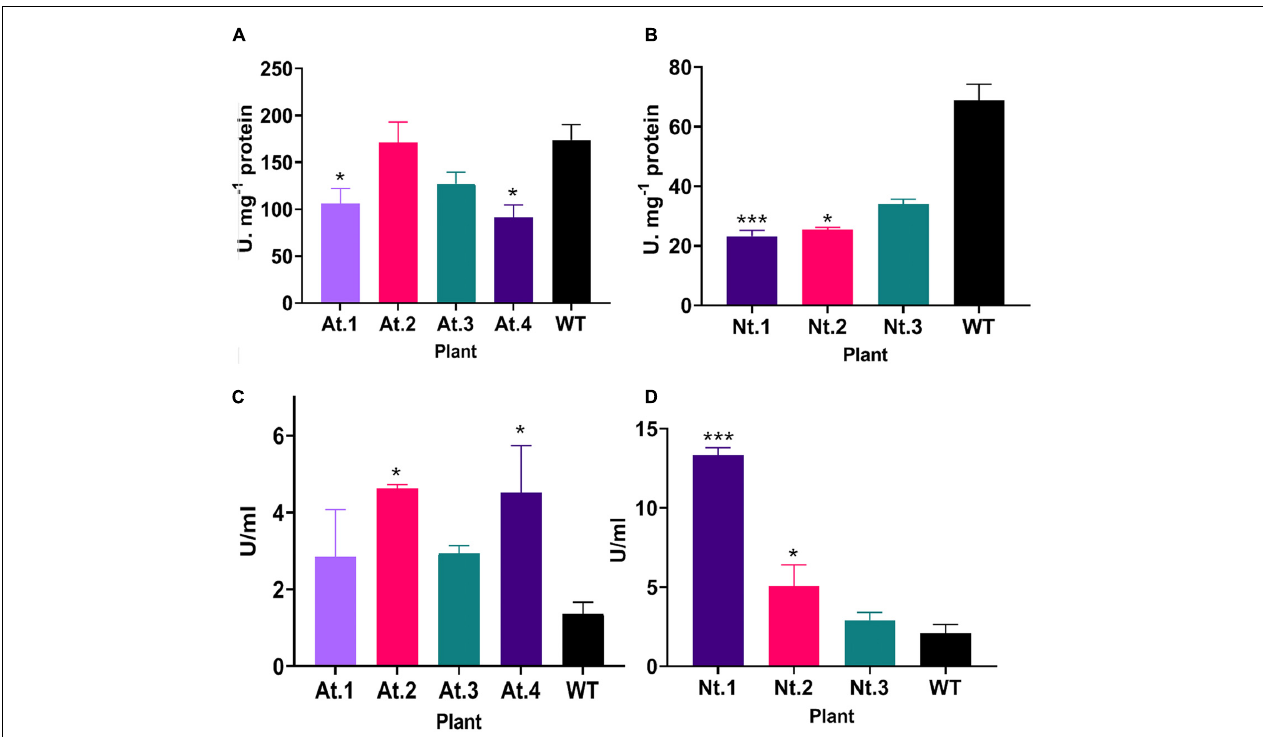
FIGURE 7 | Superoxide dismutase and peroxidase activity in transgenic Arabidopsis thaliana and Nicotiana tabacum plants. (A) SOD activity in transgenic A. thaliana plants. Plants At.1 and At.4 show a significant decrease in SOD activity compared to the wild type. (B) SOD activity in transgenic N. tabacum plants. The transgenic plants Nt.1 and Nt.2 show a significant decrease in SOD activity compared to the wild type. (C) Peroxidase activity in transgenic A. thaliana plants. Plants At.2 and At.4 show a significant increase in peroxidase activity compared to the wild type. (D) Peroxidase activity in transgenic N. tabacum plants. The transgenic plants Nt.1 and Nt.2 show a significant increase in peroxidase activity compared to the wild type. * p ≤ 0.05, ** p ≤ 0.01, *** p ≤